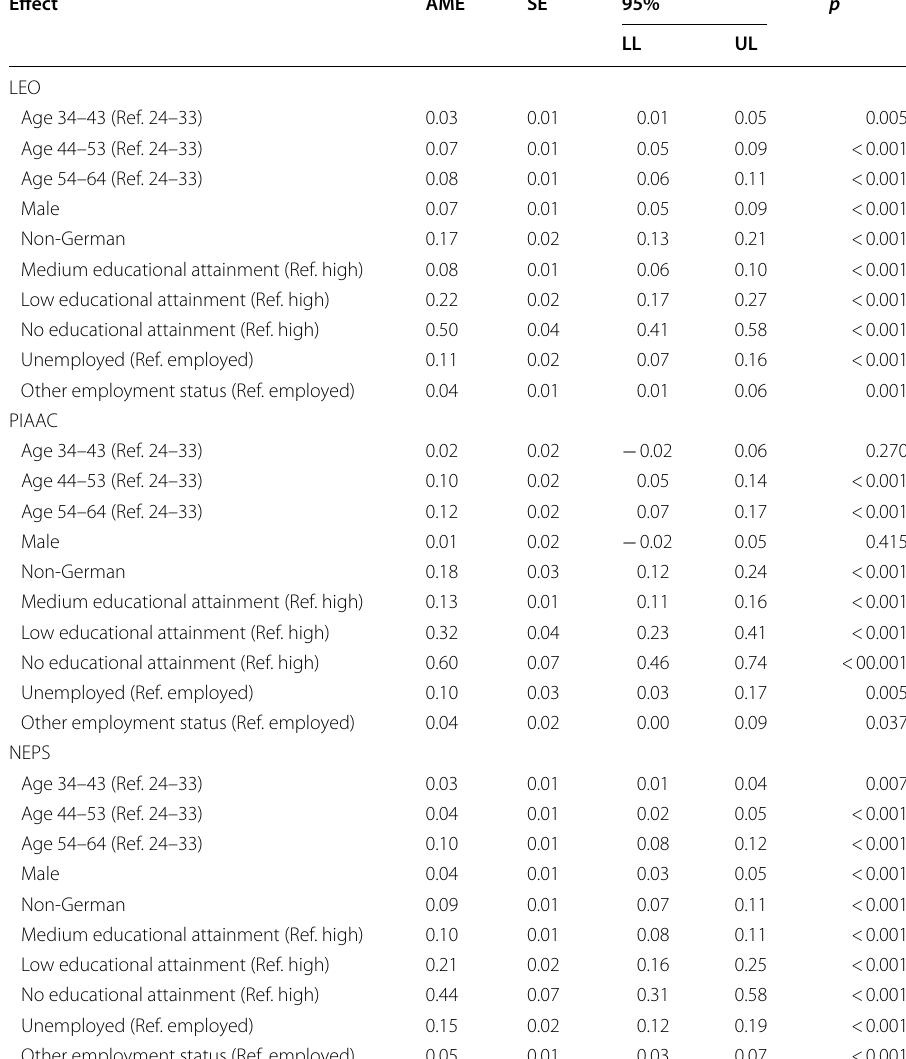
Table 6 Logistic Regression Predicting Low Literacy for LEO, PIAAC, and NEPS among all